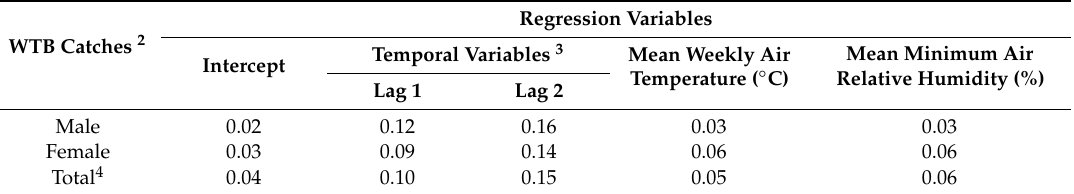
Table 3. Partial R 2 between independent and dependent variables in multiple regression models (Table 2) developed for 142 weekly trap catches of walnut twig beetle (WTB), Pityophthorus juglandis